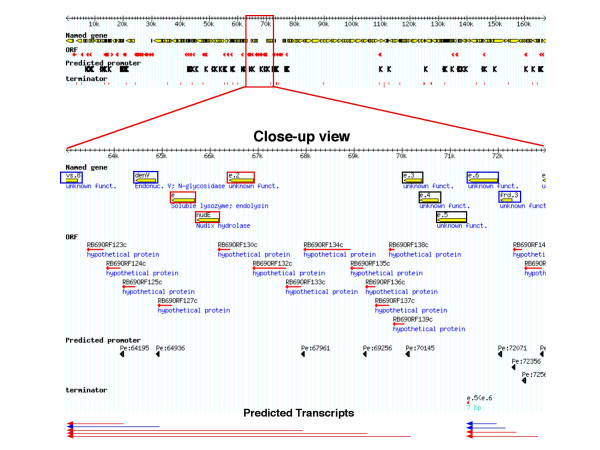
Location of early promoter sequences on the RB69 genome. The top panel shows an overview. Conserved Genes are shown as yellow arrows, novel ORFs as red line arrows, predicted early promoters are shown as large black arrows, and TransTerm [38] predicted terminators as red blocks. The bottom panel shows detail of one region. Predicted transcripts are shown at the bottom, blue arrows indicate transcripts expected from conserved gene promoters and red arrows designate those expected from novel ORF promoters. Orthologs of genes known to be expressed early in T4 infections are boxed. Red boxes indicate genes present only on predicted ORF promoter transcripts; blue-boxed genes are present on conserved and ORF promoter transcripts. Black boxes are early genes whose transcripts could not be predicted.